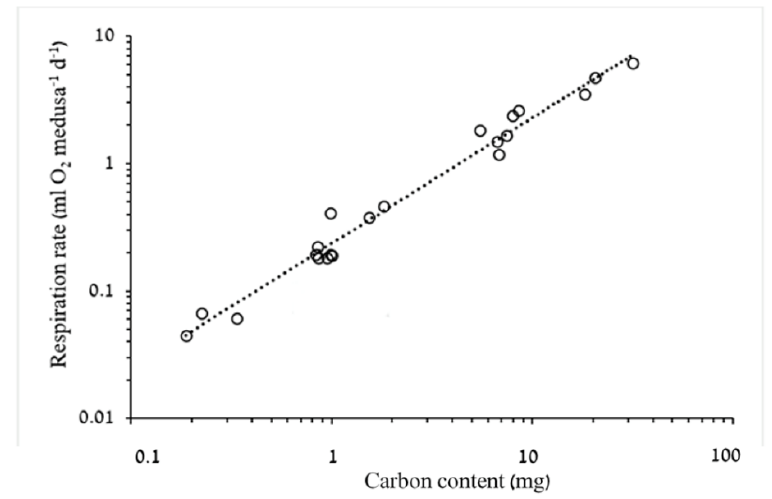
Figure 5. Log–log plots of the relationship between carbon content (C) and respiration rate (RR) ( n = 21). RR = 0.2364 × C 0.9862 , R 2 = 0.978. F 1,19 = 827, p < 0.001. Mean daily carbon demand for the medusae (assuming respiratory quotient = 0.8)